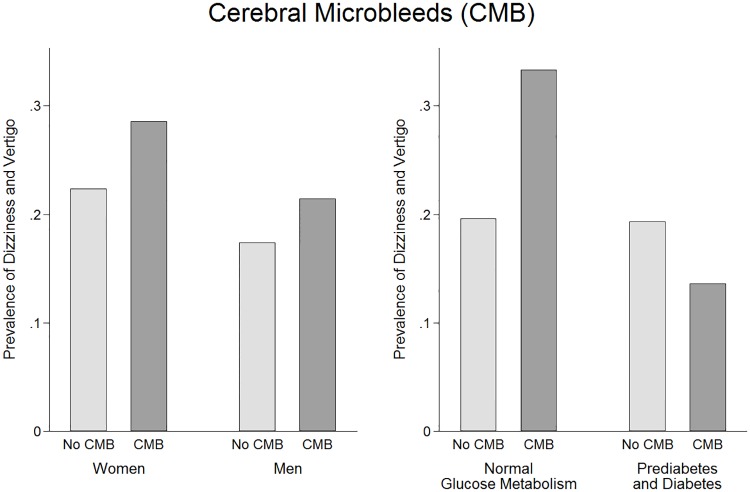
Prevalence of 12-month dizziness and vertigo according to groups with and without cerebral microbleeds.In women and men (Panel A) and in persons with normal glucose metabolism and in prediabetic or diabetic persons (Panel B).